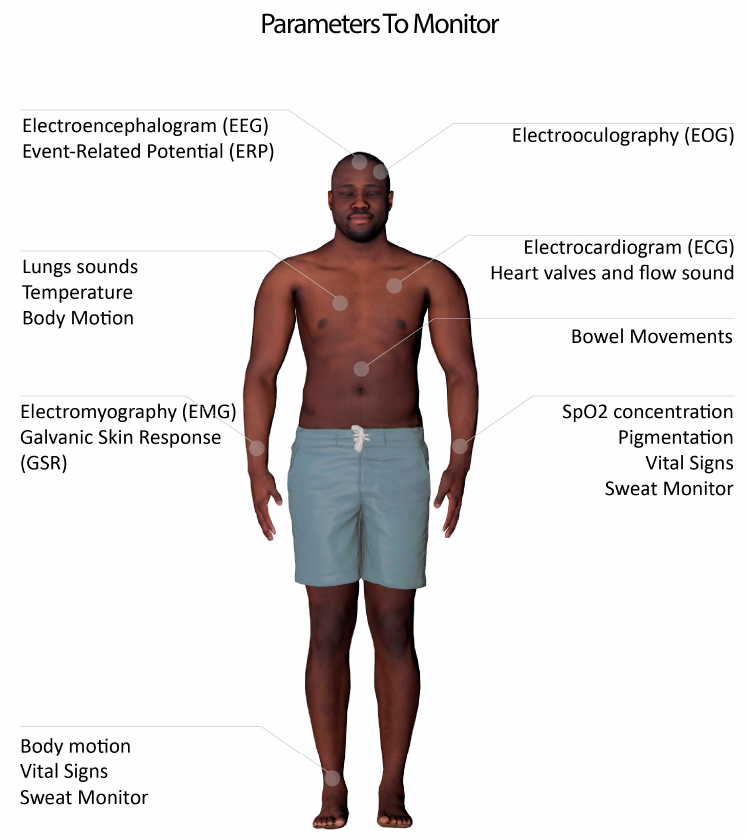
Figure 1. Parameters that can be monitored using an Internet of medical things (IoMT) system and wearable biomonitoring. Table 1. Types of Bio-signals, and most common